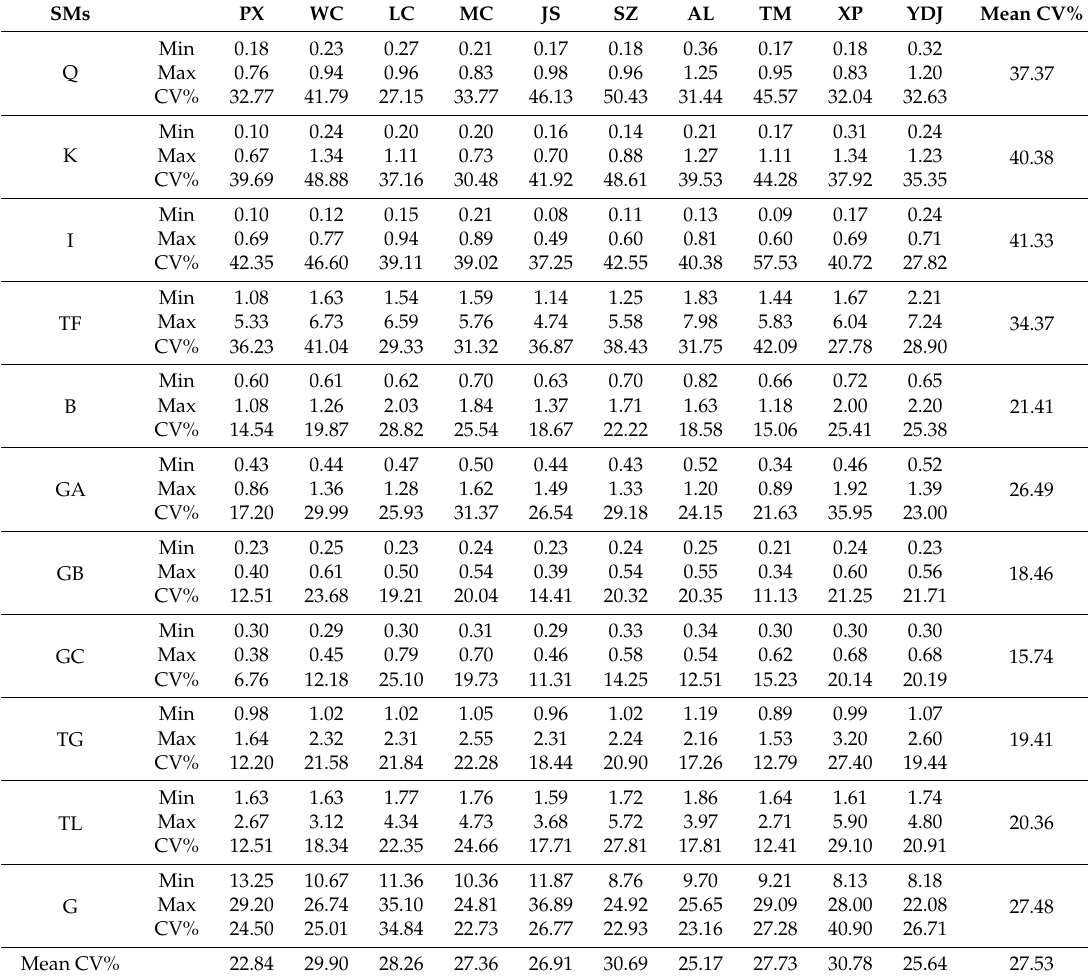
Table 5. Minimum value, maximum value and variation coefficients (CV) of concentrations of SMs within each